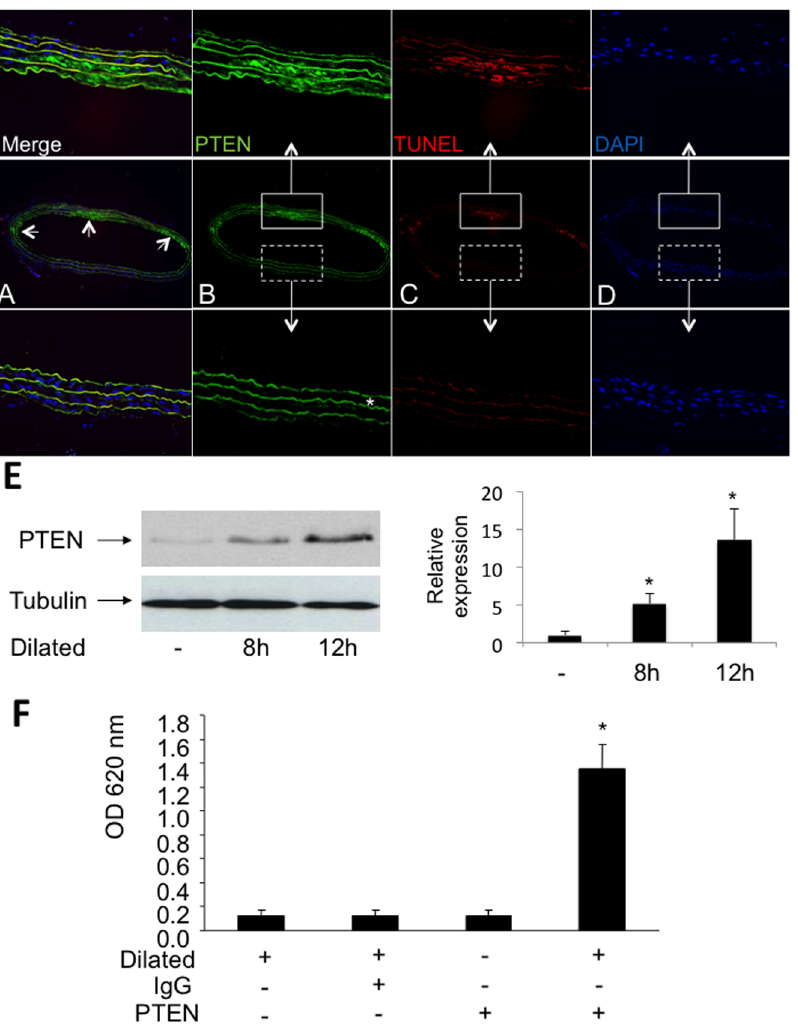
Figure 1. PTEN expression and apoptotic cells invivo . A–D , Immunoreactivity of PTEN (green), apoptotic smooth muscle cells (TUNEL staining, red) and nuclei (DAPI, blue) is shown in representative sections of an injured rat carotid artery 12 h after balloon injury. The autoflourescence of the elastic laminae (* in figure 1B) allows the identification of the media. Strongly injured areas of the dilated vessel were identified by a reduced cellularity and by the accumulation of apoptotic cells. Higher magnifications of vessel areas which fulfill these criteria are shown in the upper panel whereas higher magnifications of less injured vessel areas are shown in the lower panel. E PTEN expression is upregulated in dilated rat carotid arteries in vivo as determined by western blotting using a specific PTEN antibody. Detection of b -tubulin served as loading control. The relative expression of PTEN as determined by densitometric analysis of immunoblots is shown (n=3; * P , 0.05). F , The activity of PTEN is enhanced after vascular injury. Shown is the phosphatase activity as determined by immunoprecipitated PTEN from lysates of dilated and undilated rat carotid arteries. Immunoprecipitations employing an IgG iso-antibody and without addition of any antibodies served as controls. Results are expressed as mean OD650 6 SD (* P , 0.001,